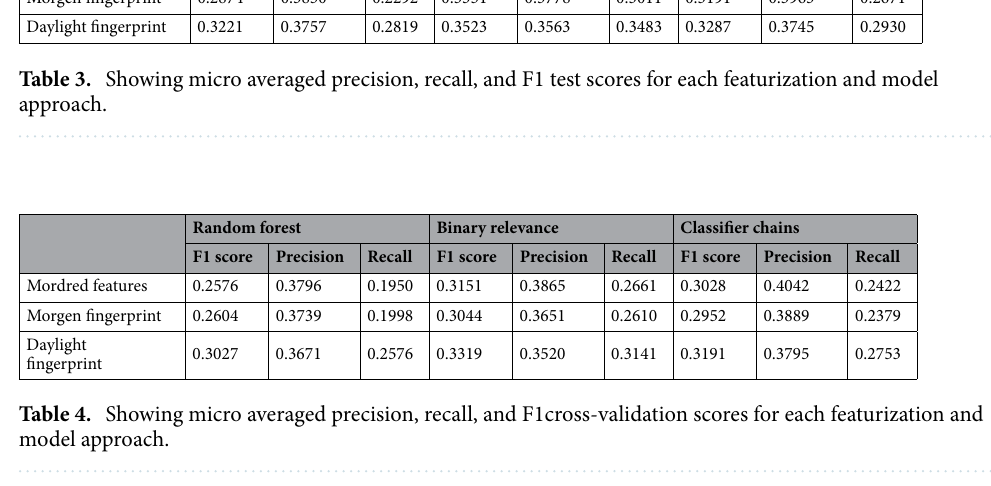
Random forest Binary relevance Classifier chains